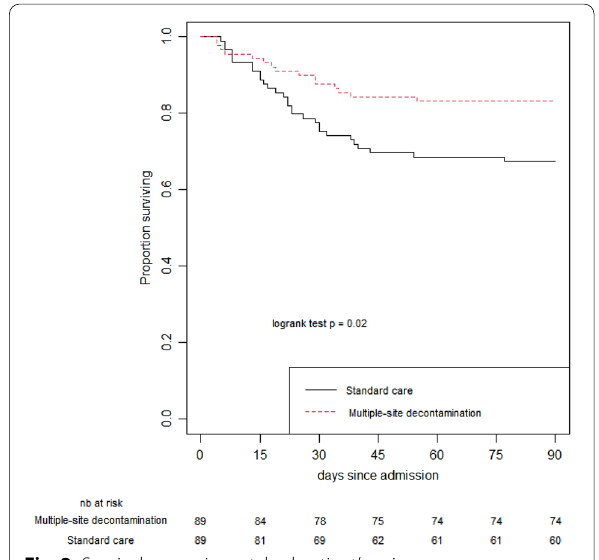
Fig. 2 Survival curves in matched patient’s